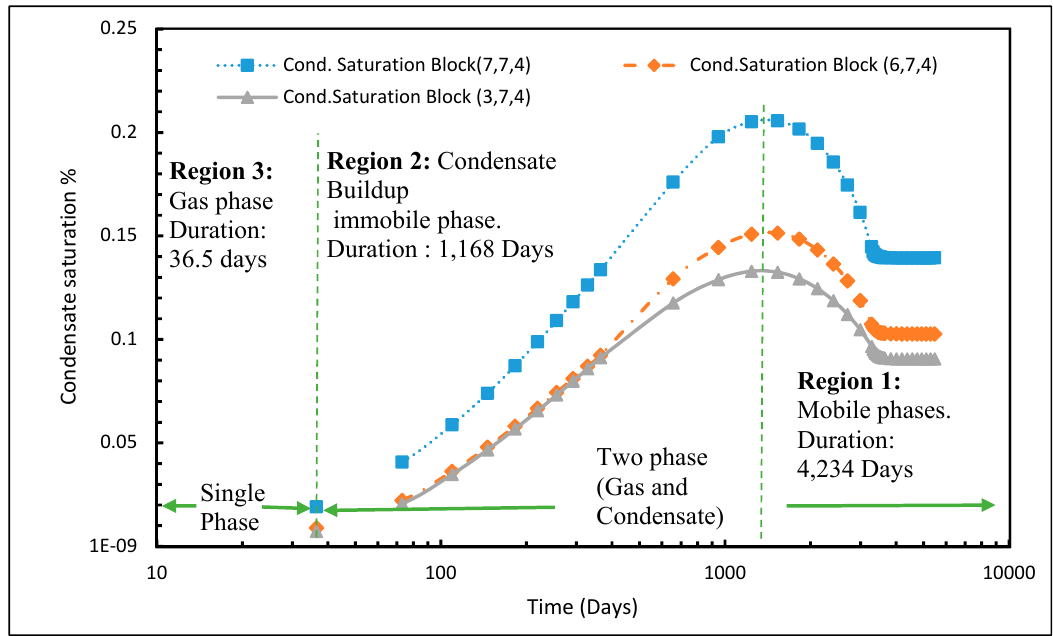
Figure 8. Condensate saturation against time and cell block location (three locations) for base case showing the different phases for three distinct regions and locations during production .